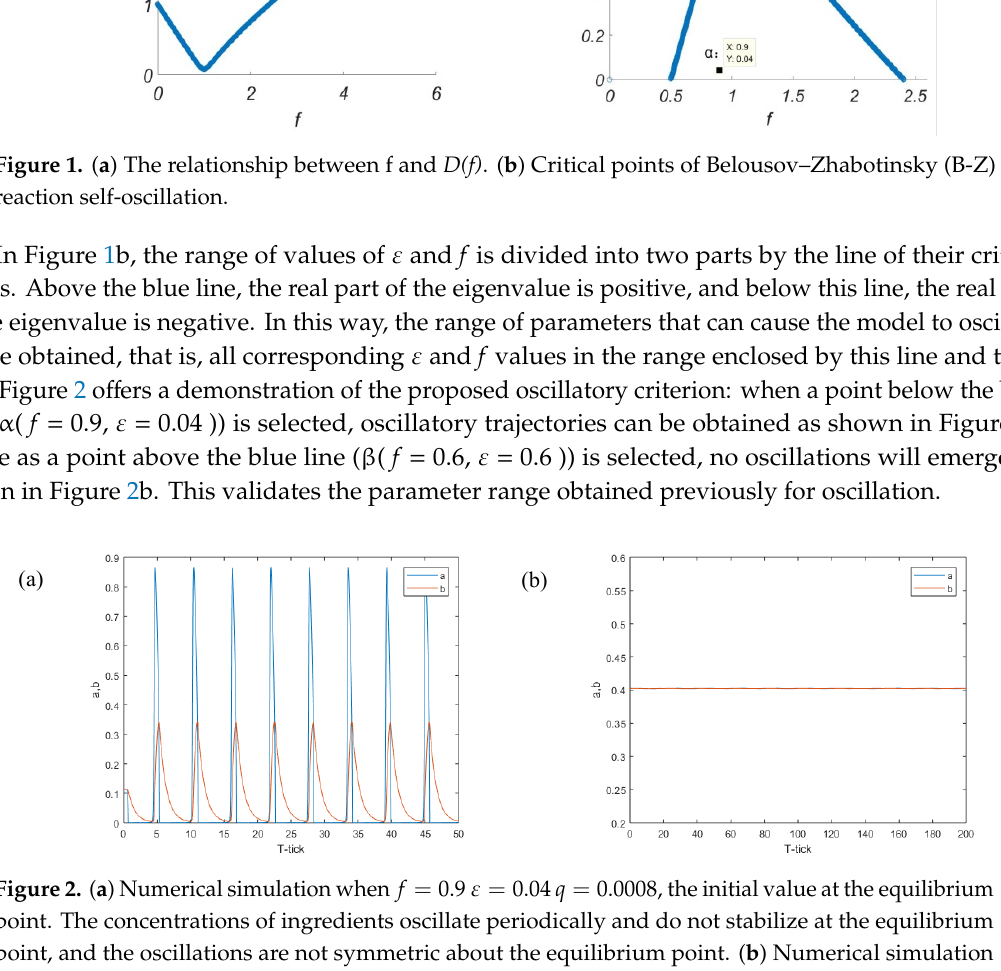
Figure 3. Take component ‘ a’ as an example, mass balance at one dot . dx and dy are the length and width of the dot , respectively. Q in,x , Q out,x are the mass feed and outlet in x direction of a , and similar in y direction. δ c,a represents the a accumulated molar amount per unit time on this dot . R c,a represents the molar amount of a generated by reaction per unit time on the dot , which is calculated by Equation (1). According to Figure 3, Equation (8) can be obtained as, 𝜕(𝑎𝑢 (cid:3051) ) 𝜕𝑥 + 𝜕𝑗 (cid:3028)(cid:3051) 𝜕𝑥 + 𝜕(cid:3435)𝑎𝑢 (cid:3052) (cid:3439) 𝜕𝑦 + 𝜕𝑗 (cid:3028)(cid:3052) 𝜕𝑦 + 𝜕𝑎 𝜕𝑡 − 𝑓(𝑎, 𝑏) = 0 (8) According to Fick's law (Equation (9), i stands for direction ( x , y , z )) and continuity equation of incompressible fluid (Equation (10)); Equation (8) is sorted out, and Equation (11) is obtained.